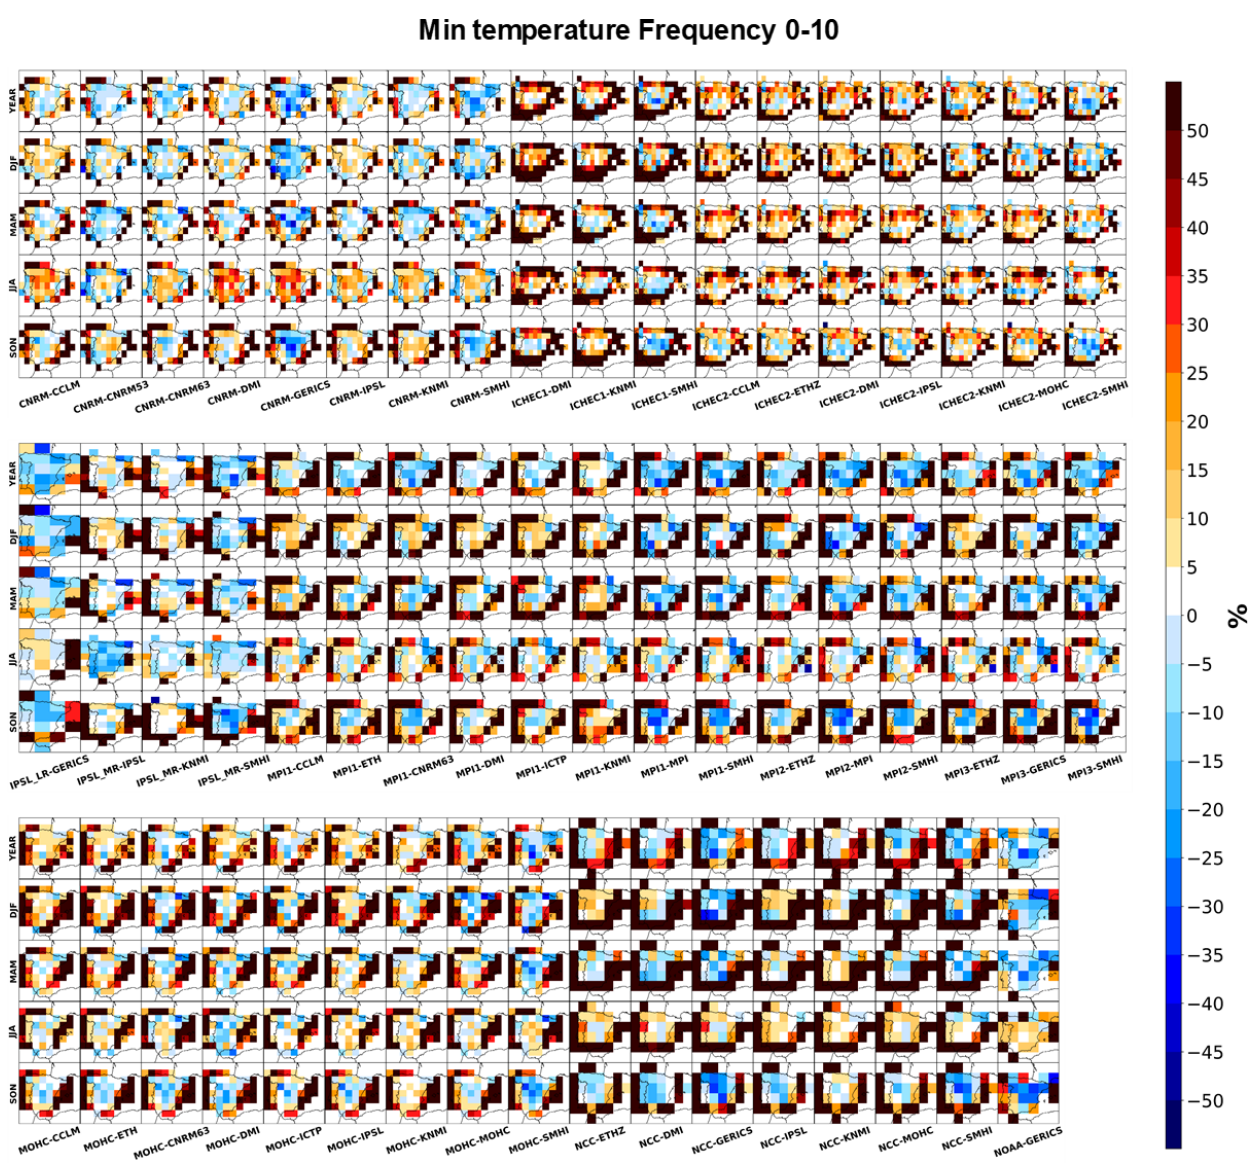
Figure 8. Yearly and seasonal distribution added values (DAVs) of the Iberian Peninsula for the historical (1971–2005) EURO-CORDEX RCMs, with the IGD as a reference for the minimum daily temperature, only considering the values below the observational 10th percentile from maximum temperatures for each GCM grid box. All RCM data were previously interpolated to 0.1 ◦ regular resolution from the observations, while the observations were interpolated into each CMI5 GCM